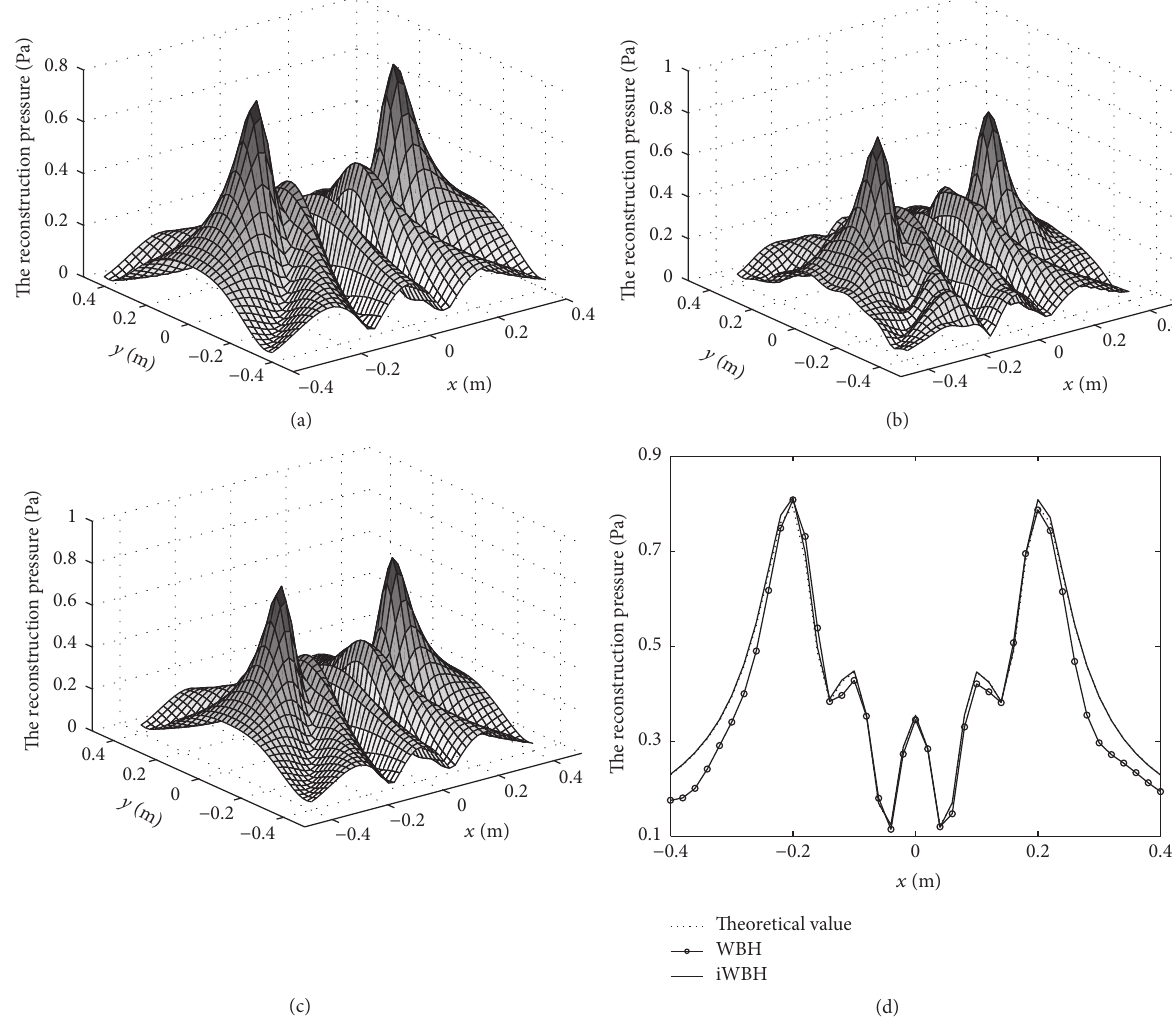
Figure 5: Comparison of reconstruction sound pressures (1800Hz). (a) Theoretical value. (b) WBH. (c) iWBH. (d) The pressure along the middle